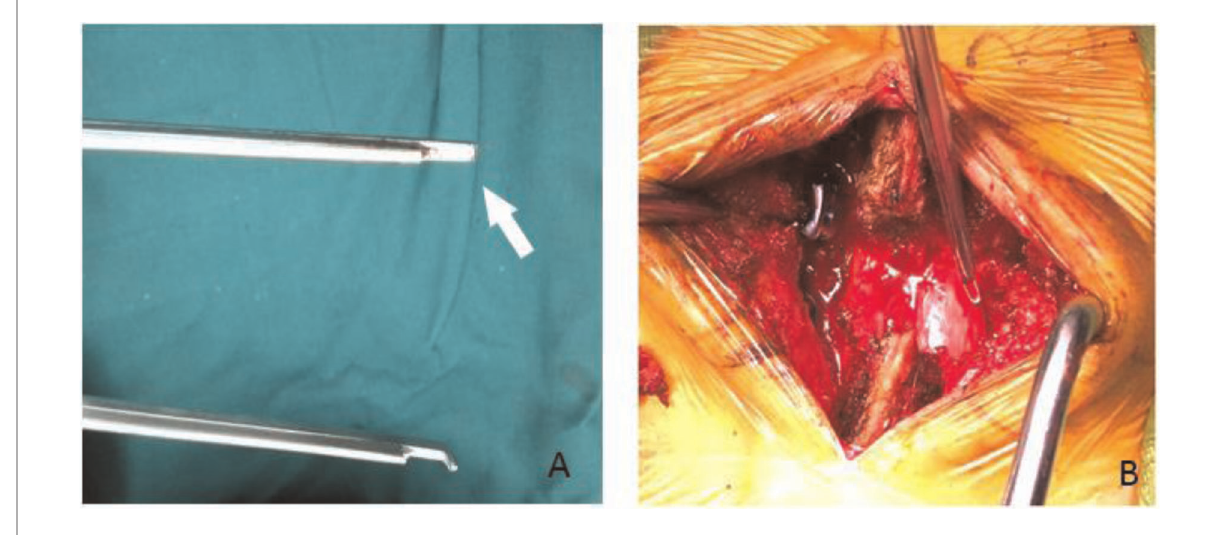
FIGURE 2 The broken rongeur (arrow) was found in the operation ( A ). The tip was not invisible in the incision ( B